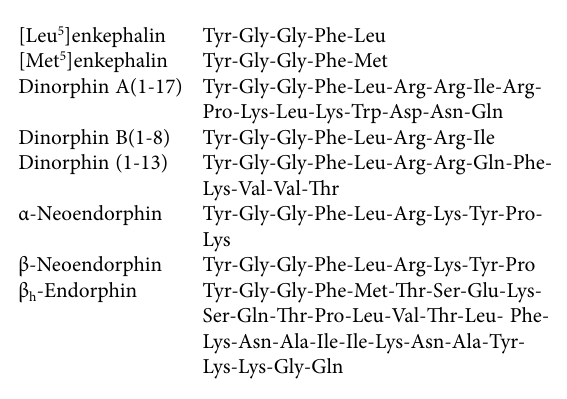
Figure 14. Endogenous Opioid Peptides: Endorphins.